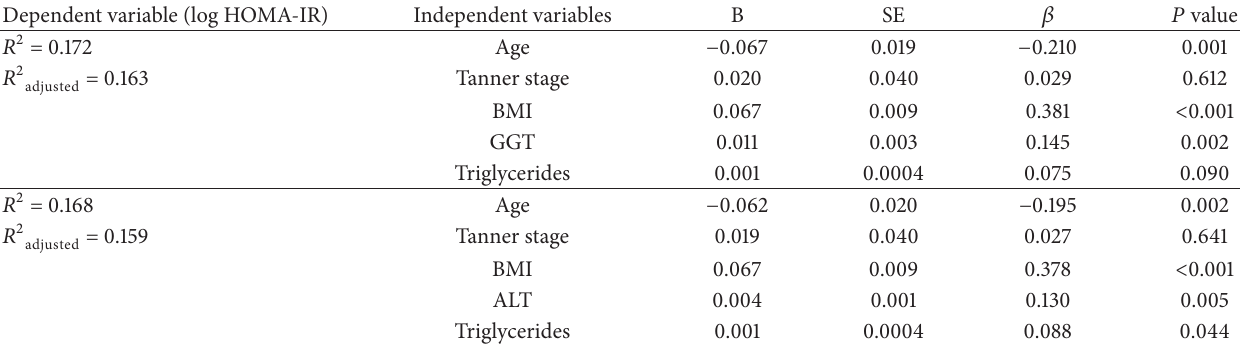
Table 5: Multiple linear regression analysis in